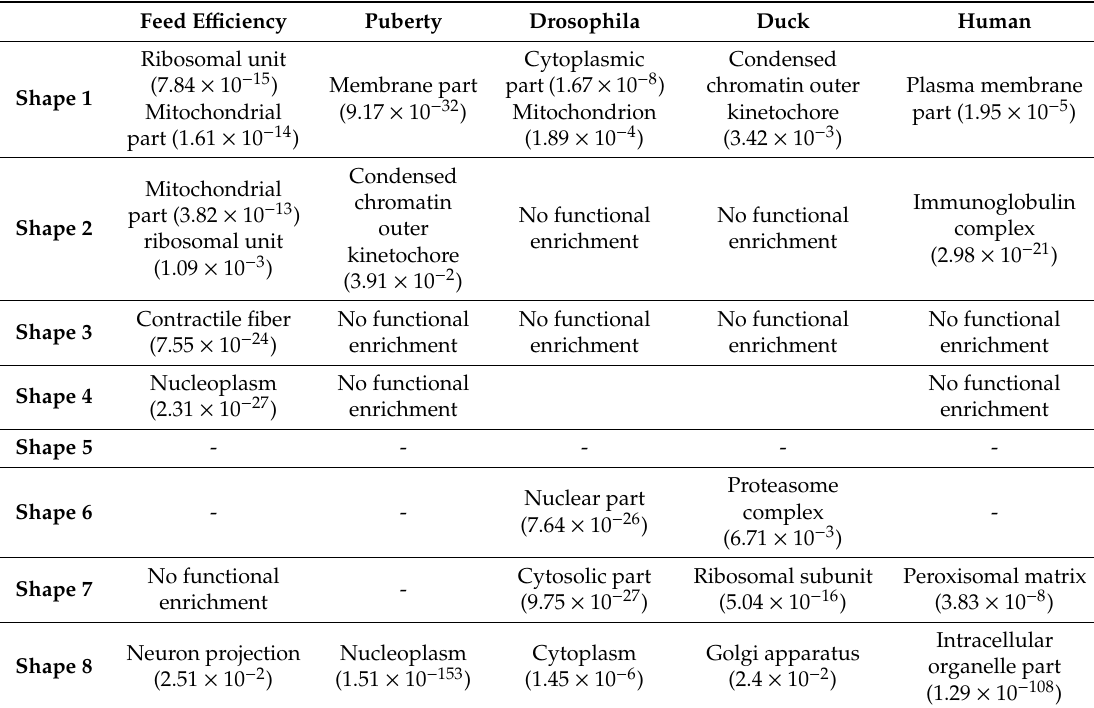
Table 1. Hypergeometric gene set enrichments for each distribution within each data set (false discovery rate q-values) based on Cellular